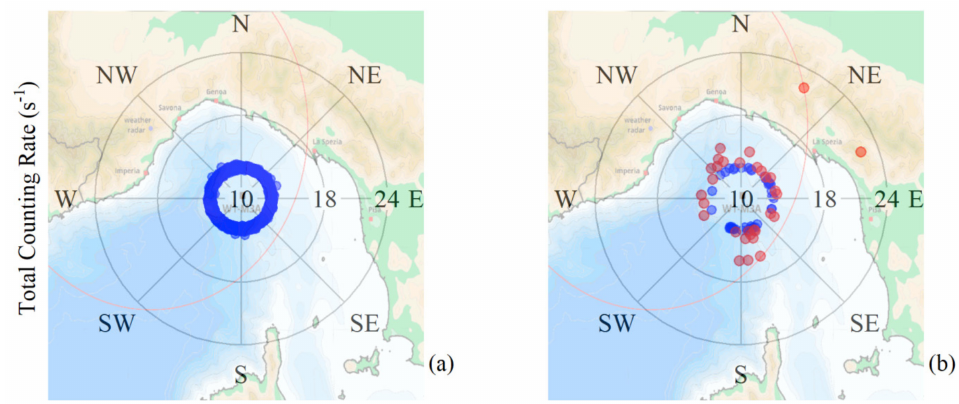
Figure 5. Analysis of TCR values with wind direction during dry meteorological conditions ( a ) and rainfalls ( b ). The events of statistically significant variation of TCR are presented with red